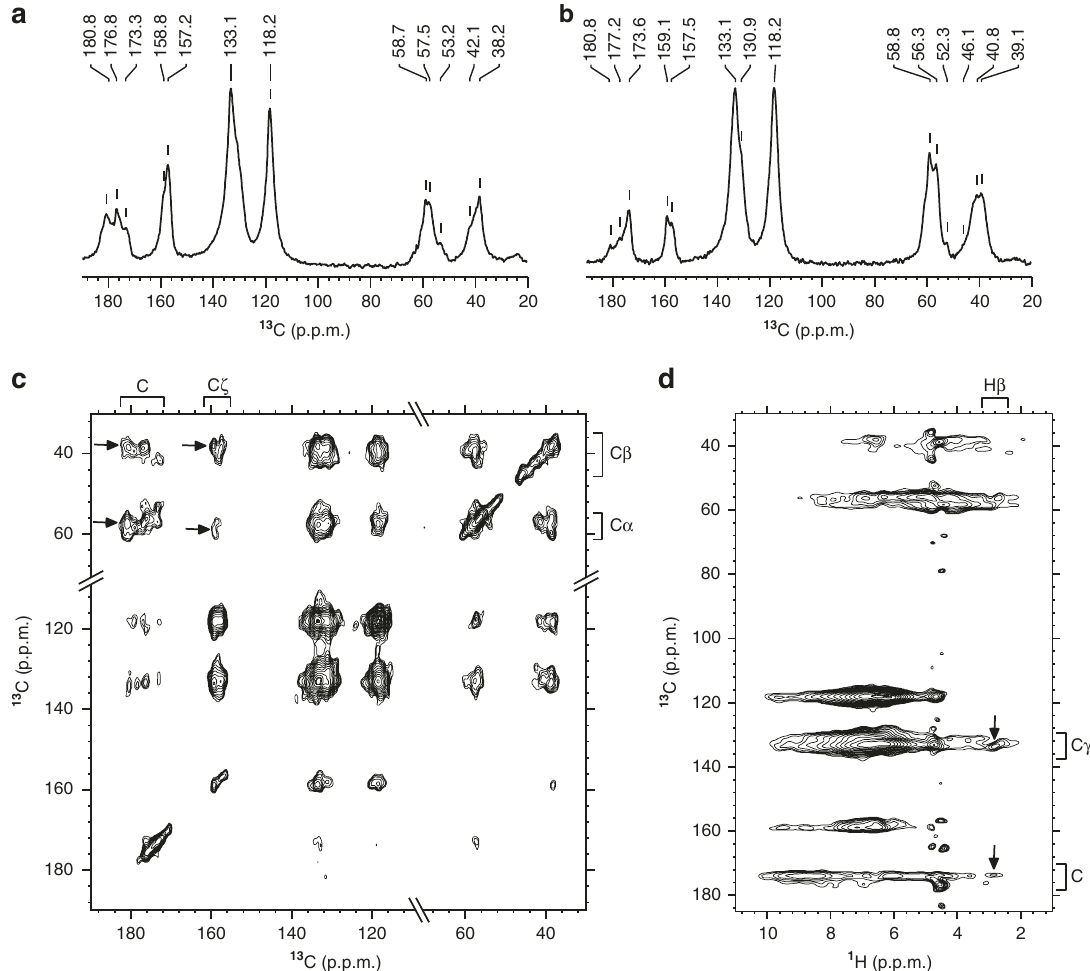
Fig. 6 Characterization of molecular interactions driving LLPS of GY-23 peptide by ssNMR. Spectra of 13 C-selectively Tyr 5 and Tyr 23 labeled GY-23: ( a ) directly observed carbon, ( b ) 1 H- 13 C cross-polarization (CP)-based with carbon detection, ( c ) DARR (100 ms mixing time), and ( d ) 1 H- 13 C HETCOR (100 μ s mixing time). Examples of correlations indicating Tyr – Tyr interactions are marked with